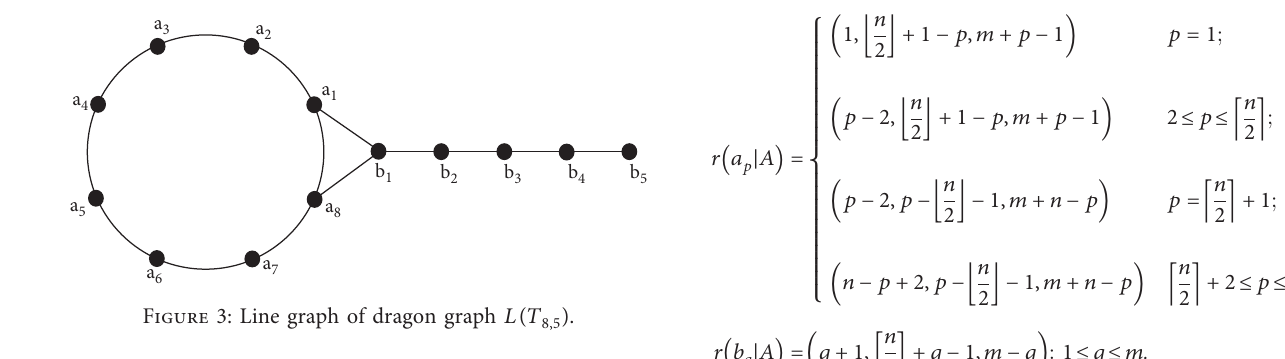
Figure 3: Line graph of dragon graph L ( T